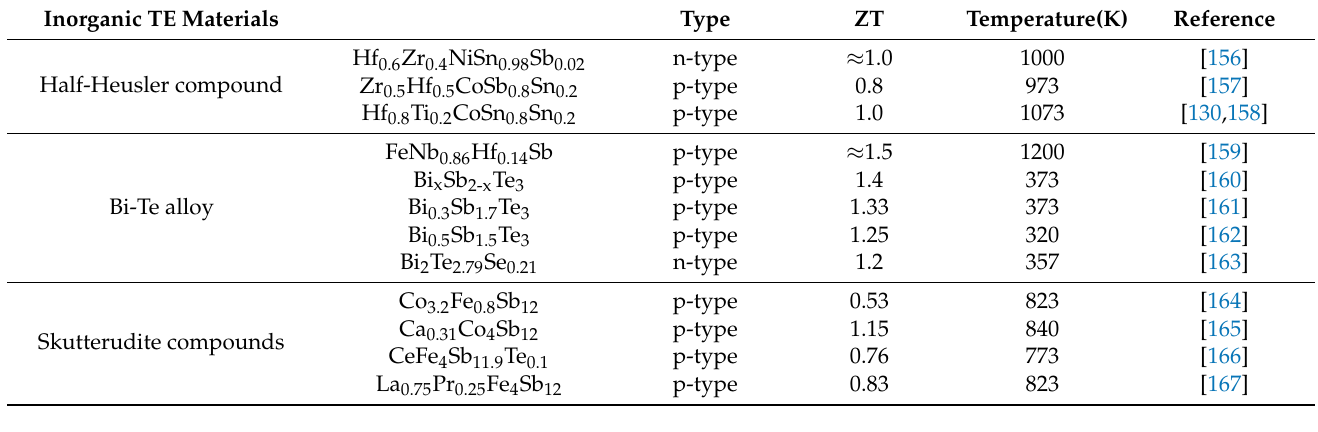
Table 1. Popular inorganic TE materials.